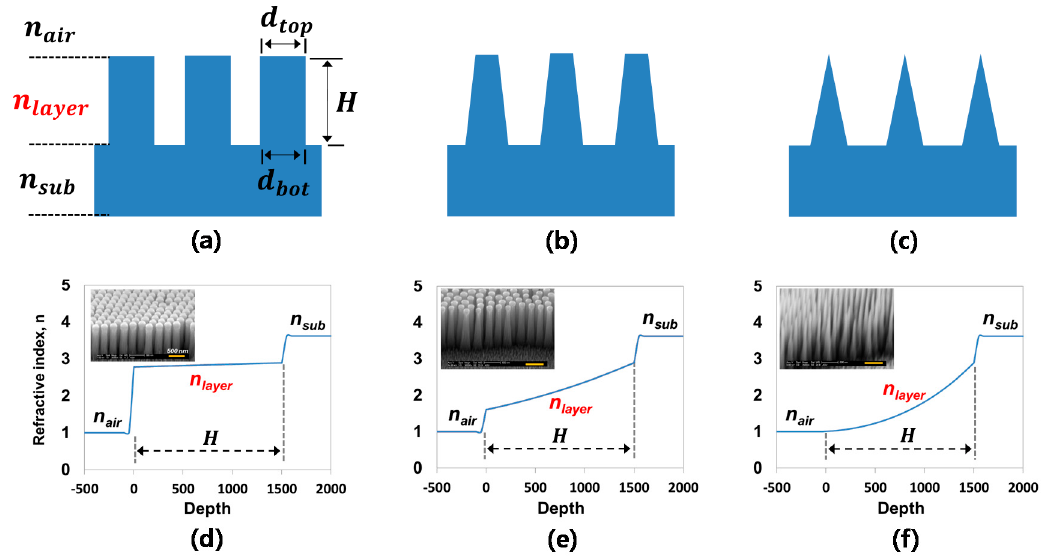
Figure 5. SEM images of ( a ) d top = d bottom , ( b ) d top < d bottom , and ( c ) d top << d bottom of nanostructures and ( d – f ) degree of refractive index change along with each nanostructured layer (Note: scale bar is 500 nm in SEM images).